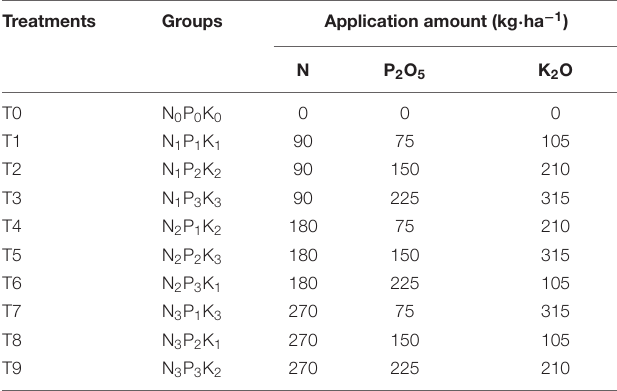
TABLE 1 | Types and amounts of fertilization designed by L 9 (3 4 ) orthogonal